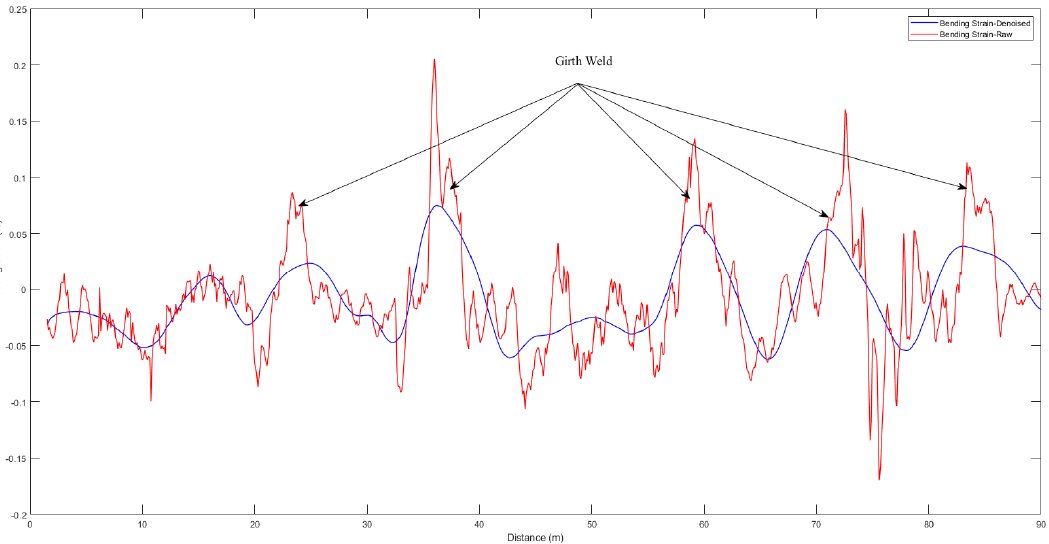
Figure 2. Comparison of the pipeline bending strain before and after the application of the denoising process. ing